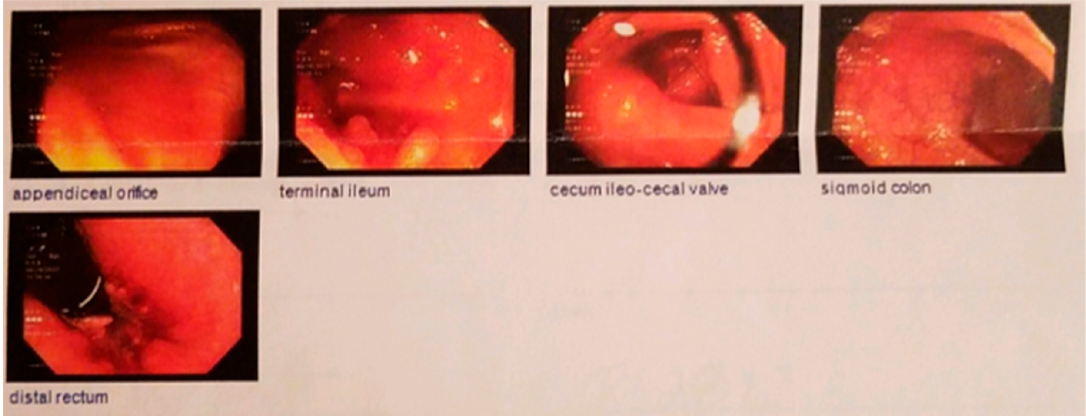
Figure 2. Follow-up ileo-colonoscopy August 2017: complete mucosal healing with no endoscopic evidence of Crohn’s disease.